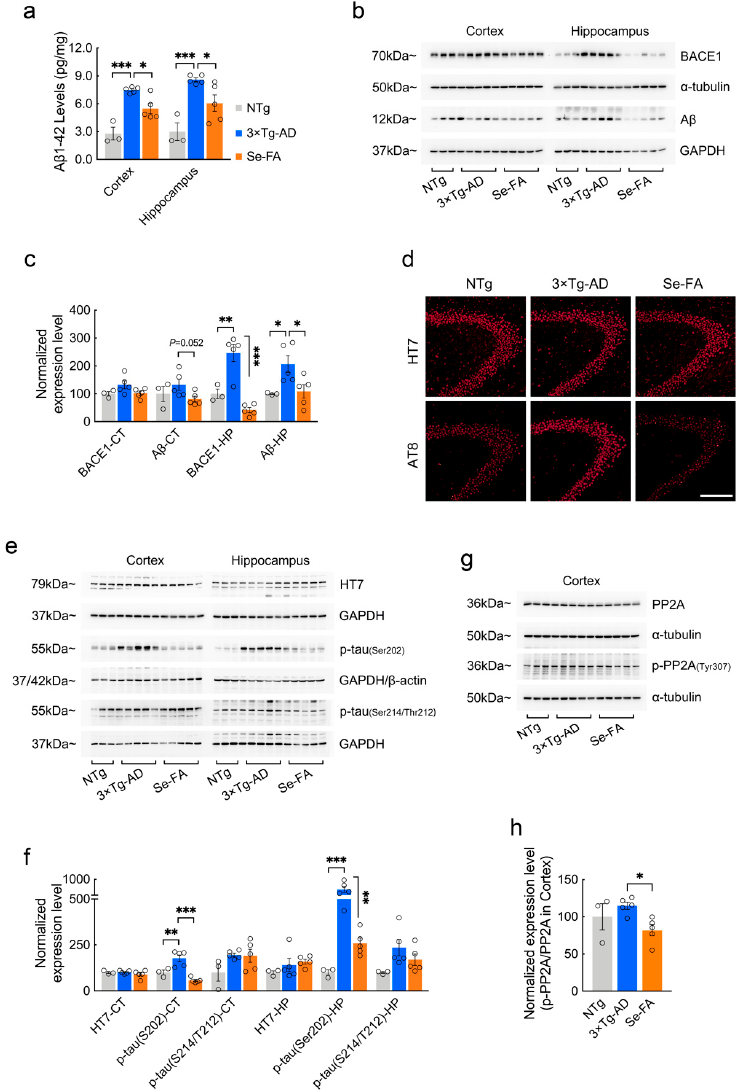
Figure 5. Se-FA inhibits A β production and tau hyperphosphorylation in 3 × Tg-AD mice. ( a ) A β 1-42 levels in the cortex and hippocampus of 7-month-old 3 × Tg-AD mice measured by ELISA (n = 3 or 5 mice). ( b ) Levels of BACE1 and A β oligomers were analyzed by immunoblot in the cortex and hippocampus of 3 × Tg-AD mice. ( c ) Quantitation of the protein levels in ( b ) (n = 3 or 5 mice). ( d ) Representative total tau (HT7) and pS202-tau (AT8) immunostaining in the CA3 area of the hippocampus of NTg-, 3 × Tg-AD- and Se-FA-treated mice (Scale bar: 50 µ m). ( e ) Levels of total tau and p-tau (Ser202 and Ser214/Thr212) in the cortex and hippocampus of experimental mice were analyzed by immunoblotting. ( f ) Quantitation of the protein levels in e (n = 3 or 5 mice). ( g ) Levels of PP2A and p-PP2A (Tyr307) in the cortex of 3 × Tg-AD mice were analyzed by immunoblotting. ( h ) Quantitation of the protein levels in g (n = 3 or 5 mice). α -Tubulin, β -actin or GAPDH was used as a loading control. All the mice were fed diets with Se-FA or a control diet for 12 weeks. All data are presented as the mean ± SEM. * p < 0.05, ** p < 0.01, *** p < 0.001 as determined by one-way ANOVA followed by Dunnett’s multiple comparison